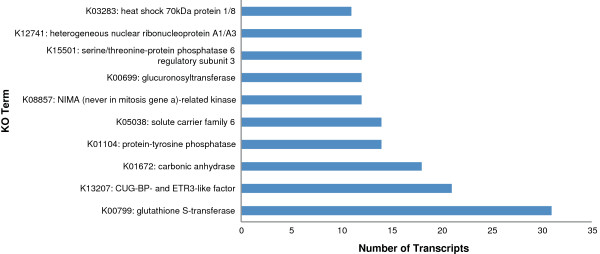
KO annotations. Top 10 represented KO terms from the KAAS annotation results.